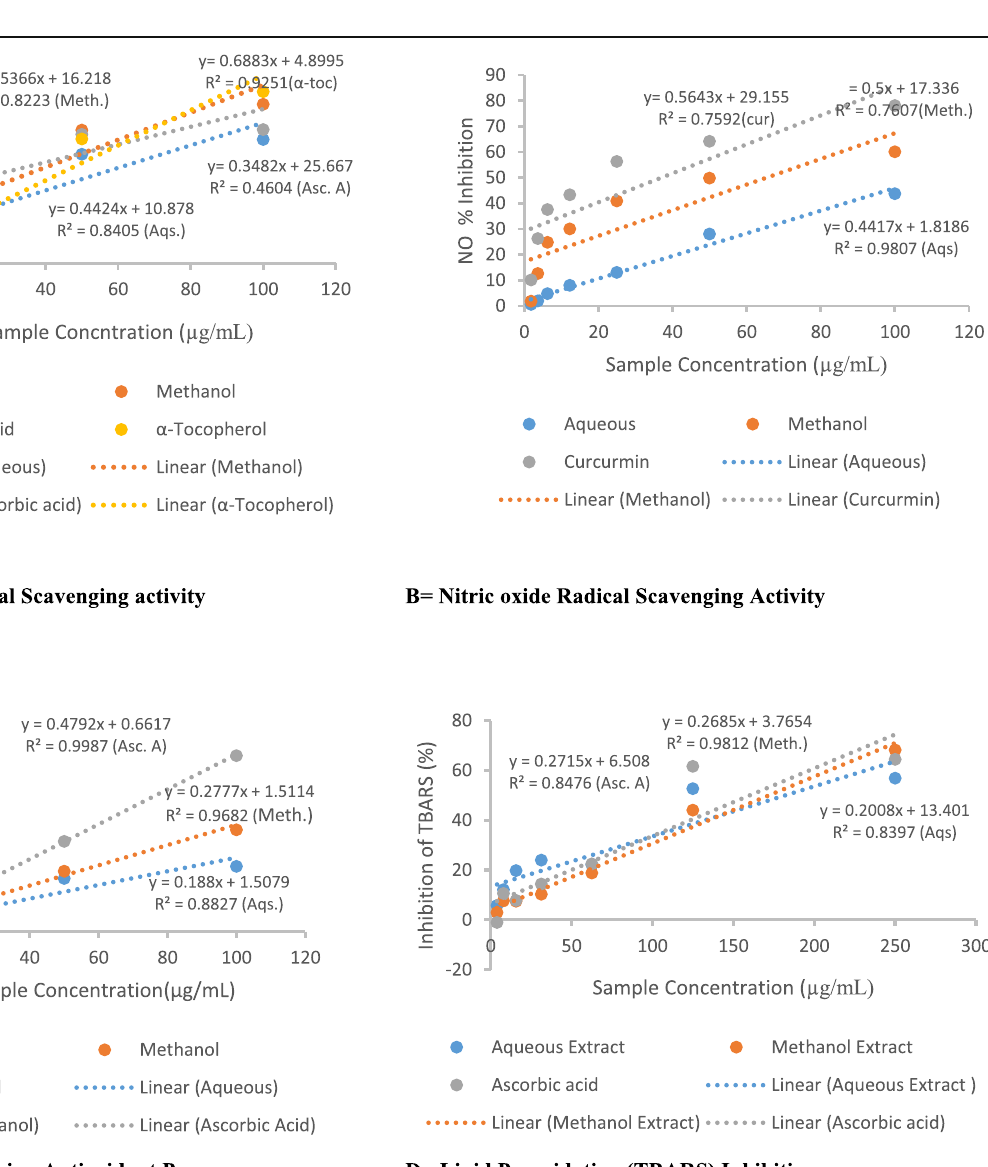
Fig. 1 In vitro antioxidant activities of Dennettia tripetala leaf